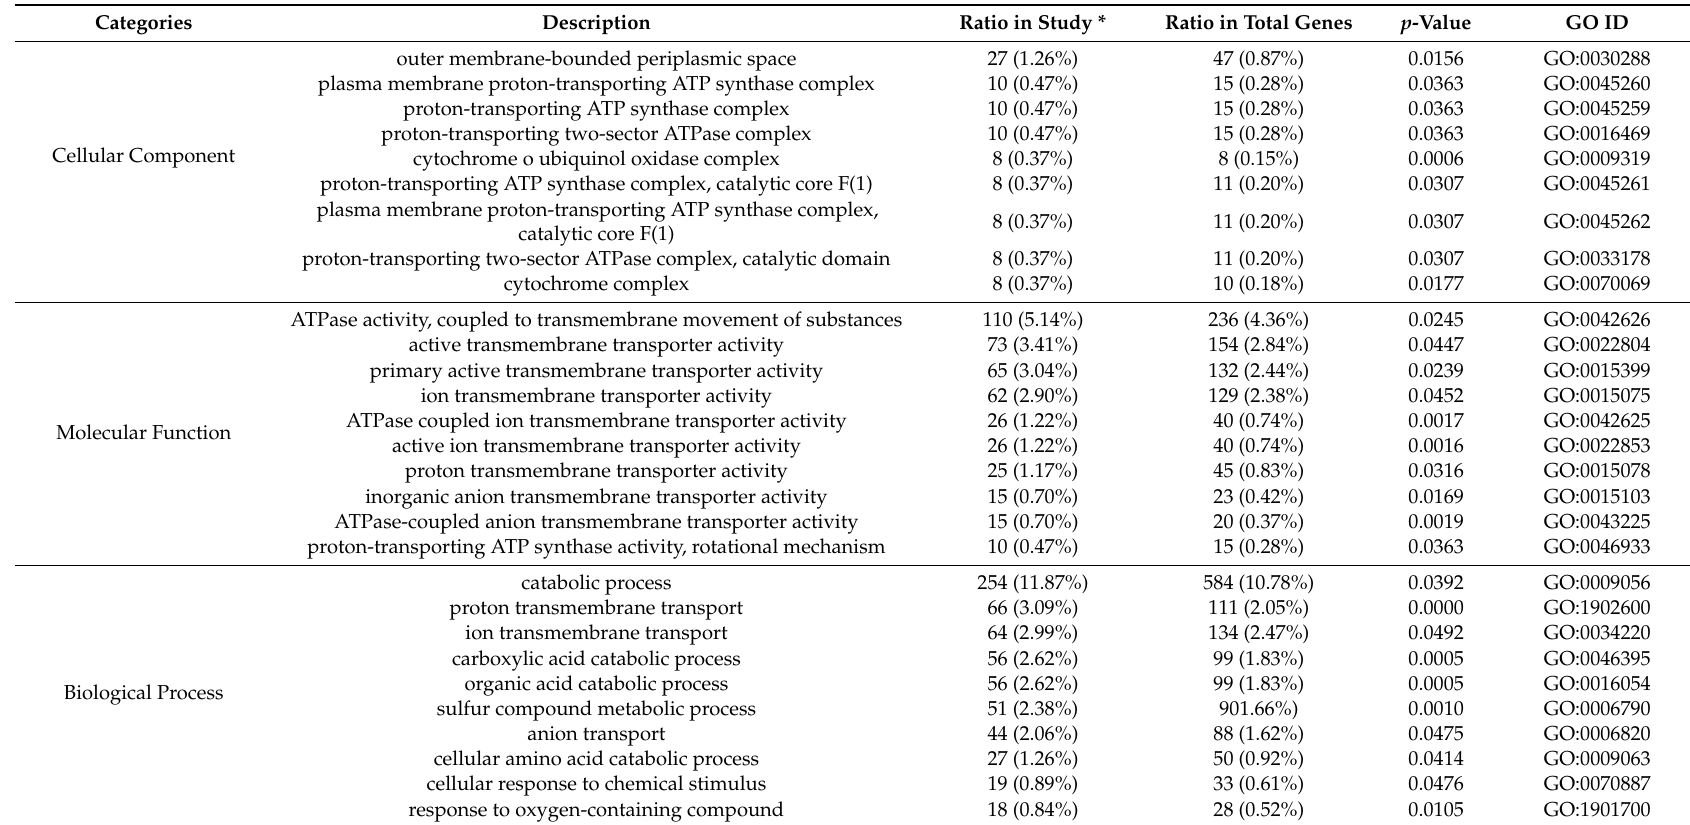
Table 2. Control (MC1-CK) vs. salt-treated (MC1) GO